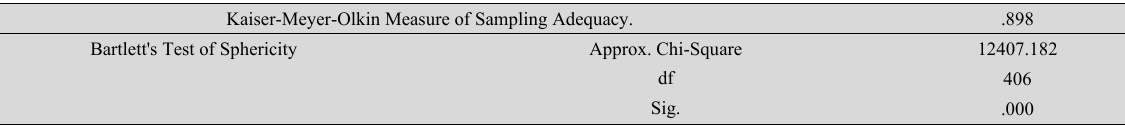
The results of KMO and Bartlett’s test Kaiser-Meyer-Olkin Measure of Sampling Adequacy.